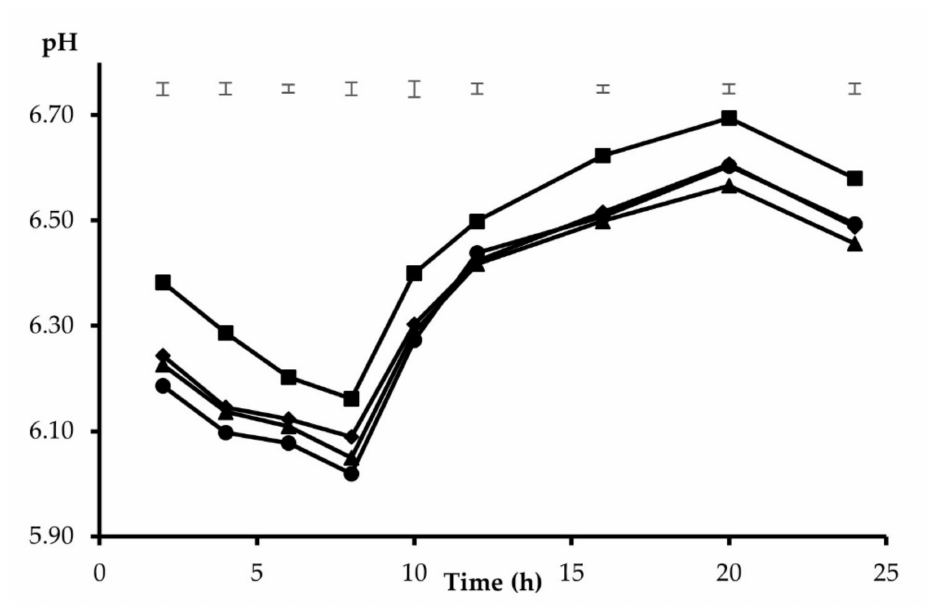
Figure 1. Pattern of pH changes of a 65:35 concentrate-to-forage (HC) substrate, incubated alone (C: ) or supplemented with 10 mg/g of zeolite (Z: (cid:4) ), bentonite (B: (cid:117) ), or sepiolite (S: (cid:115) ). Initial pH (cid:32) was 6.62 ± 0.16. Upper bars show standard error of means ( n = 4).